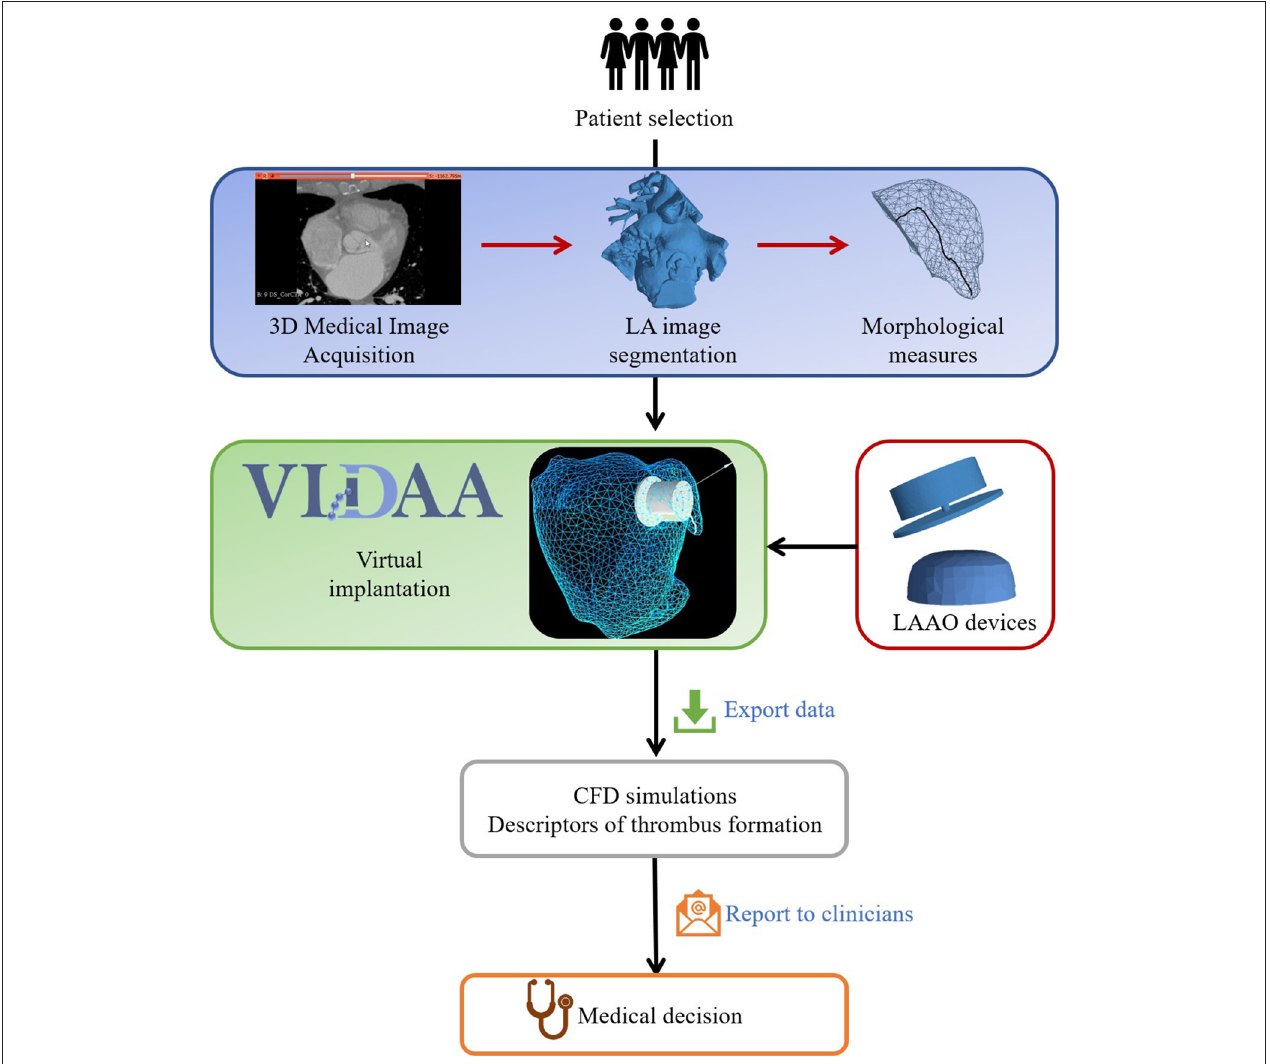
FIGURE 2 | Computational workflow to recommend optimal left atrial appendage occlusion (LAAO) settings for a selected patient. The first stage produces LAA morphological measures from LA segmentations obtained on three-dimensional medical images. Computational 3D renderings of LA/LAA geometries are then jointly visualized with morphological measures and Computer-Aided Design models of LAAO devices in the VIDAA platform. The VIDAA platform allows an interactive and individualized virtual implantation of LAAO devices, generating multiple configurations that can be exported for further processing. Computational-Fluid Dynamics (CFD) simulations run on the exported LAAO configurations provide hemodynamics descriptors to estimate the risk of thrombus formation for each case, which are finally reported to clinicians to support their